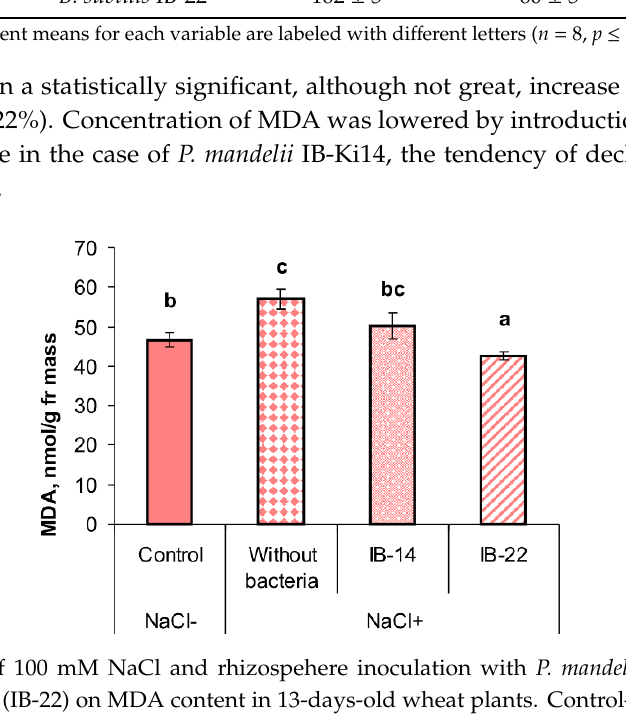
Table 4. Effects of 100 mM NaCl and rhizosphere inoculation with P. mandelii IB-Кi14 and B. subtilis